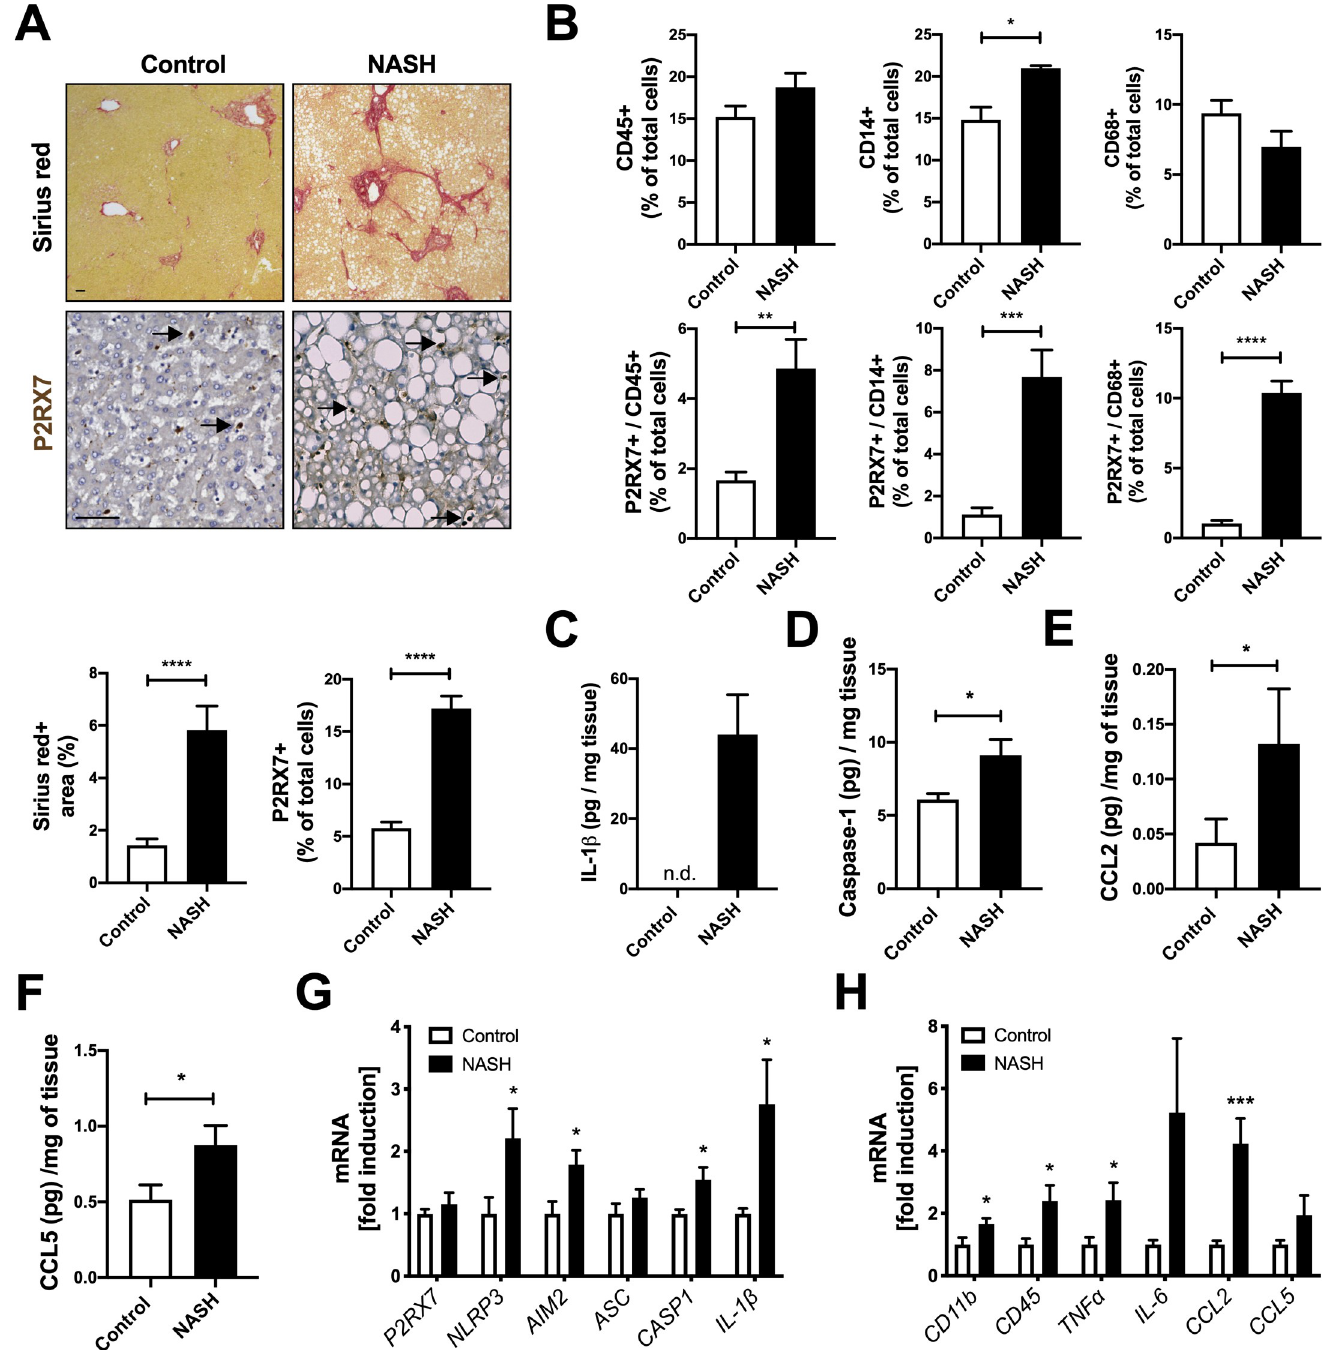
Fig 1. P2RX7 and inflammasome activation are increased in NASH-affected liver. (A) Representative images (objective 2X) of Sirius red staining (top) and immunohistochemical staining (objective 40X) of P2RX7 (bottom) in liver tissue from a representative control and NASH-affected donor with quantification of Sirius red + area and P2RX7 + cells ( n = 5 individuals per group; n = 6–8 images per donor). Scale bar, 100 μ M. Black arrows highlight P2RX7 + cells. (B) Quantification of CD45 + , CD45 + / P2RX7 + , CD14 + , CD14 + / P2RX7 + , CD68 + , CD68 + / P2RX7 + cells ( n = 5 individuals per group; n = 6–8 images per donor). (C) IL-1 β , (D) caspase- 1, (E) CCL2, and (F) CCL5 levels in liver tissue from control and NASH-affected liver biopsies ( n = 5 individuals per group). (G) Relative expression levels of P2RX 7, NLRP3 , AIM2 , ASC , CASP1 , IL-1 β and (H) CD11b , CD45 , Tnf α , Il-6 , CCL2 , CCL5 in liver tissue from control and NASH-affected donors ( n = 5 individuals per group). n.d., for not detected. In all statistical plots, the data are shown as the mean ± SEM. � P � 0.05, �� P � 0.01, ��� P � 0.001, ���� P � 0.0001 by two-sided Student’s